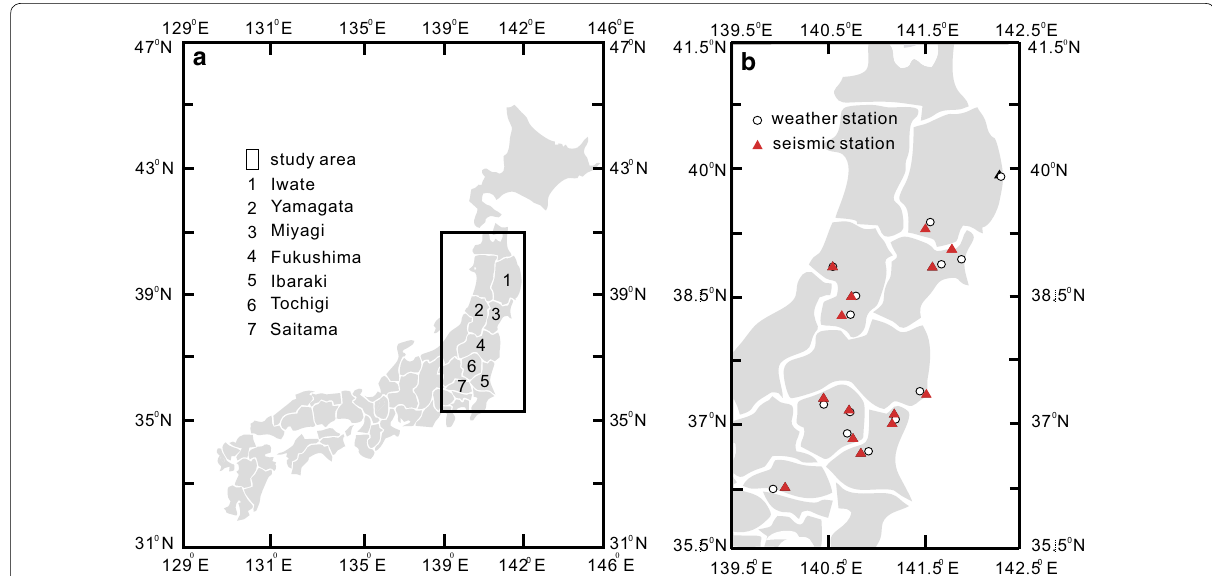
Fig. 1 a Study area. The selected seismic stations are distributed in seven prefectures of Northeast Honshu. b Magnification of the study area in Fig. 1a. The solid triangles represent the seismic stations, and the hollow circles represent the weather stations